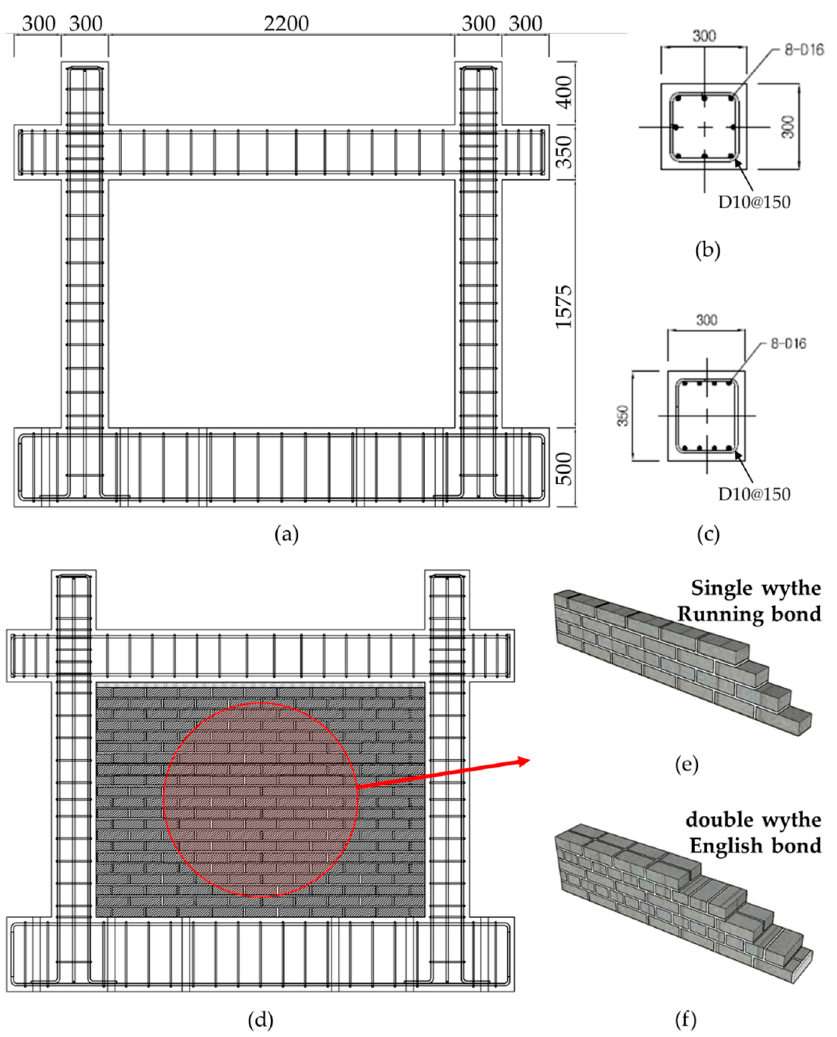
Figure 2. Details of a test specimen (unit: mm). ( a ) Dimension of specimens. ( b ) Column section. ( c ) Beam section. ( d ) Masonry-infilled frames. ( e ) Masonry wall in IF-0.5 & IFS-0.5. ( f ) Masonry wall in IF-1.0 &